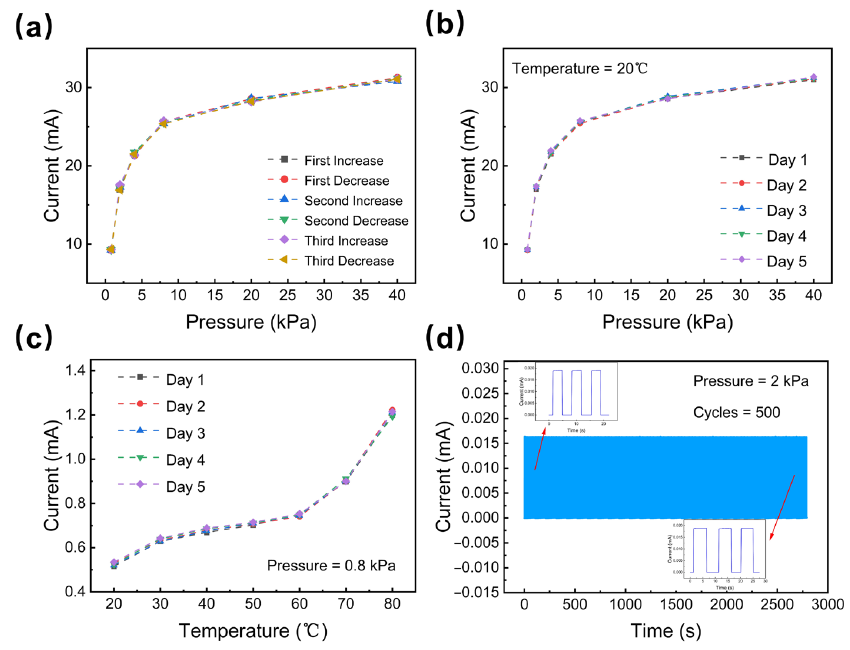
Figure 6. The durability and stability of the sensor ( a ). The pressure hysteresis of the sensor ( b ) and ( c ) the stability of the sensor. ( d ) The durability of the sensor. ( c ) the stability of the sensor. ( d ) The durability of the